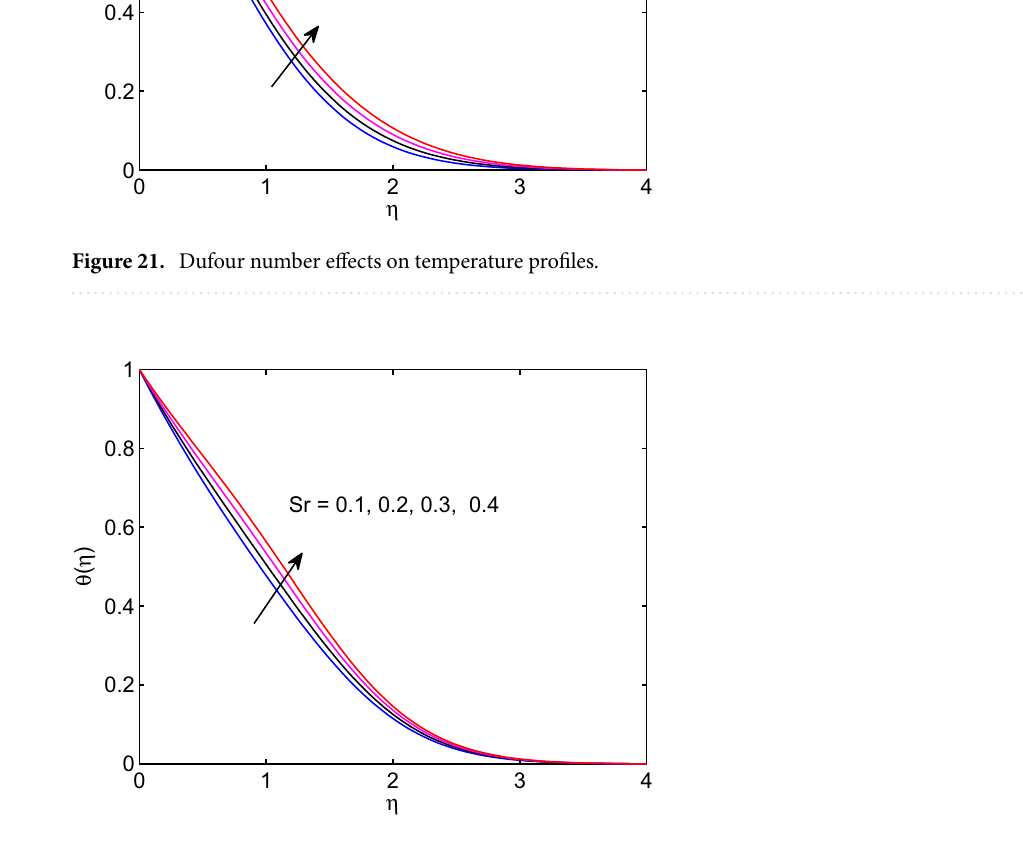
Figure 22. Soret number effects on volumetric concentration